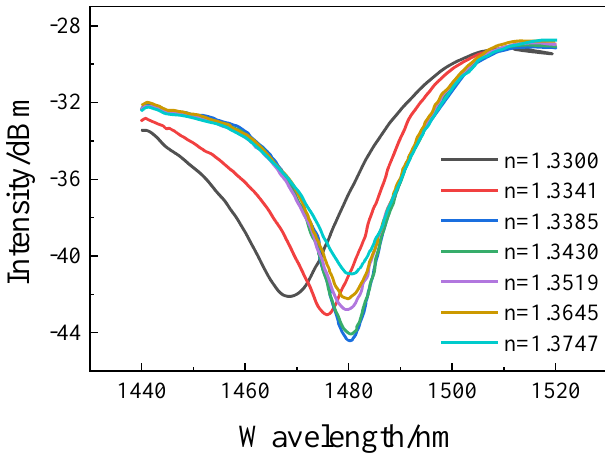
Figure 8. The transmission spectrum under different refractive index after coated GO.